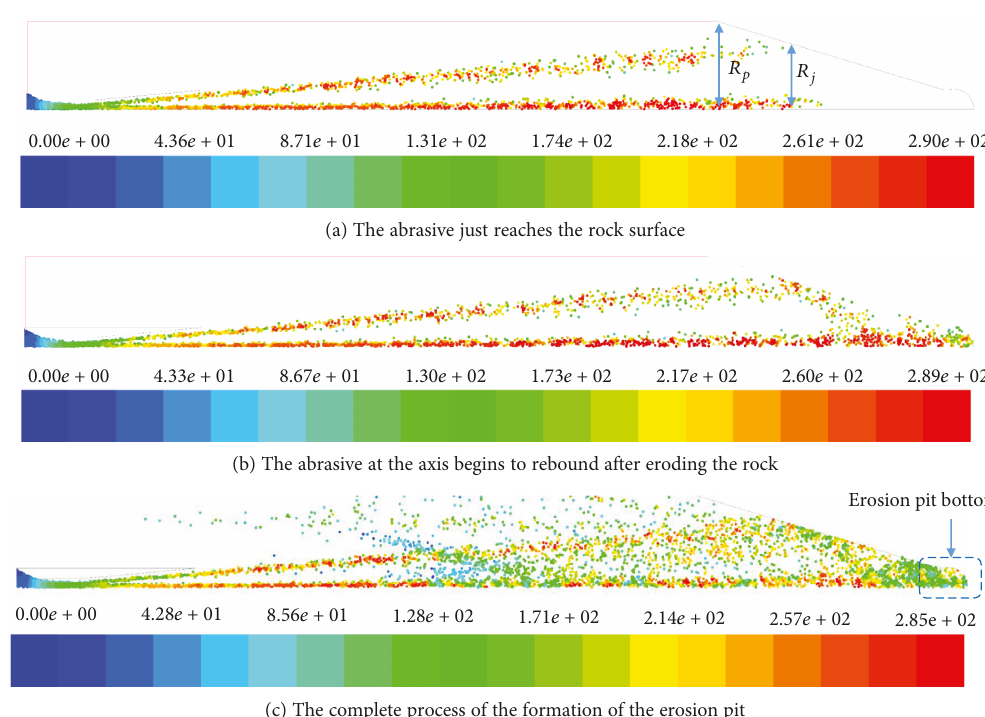
Figure 8: Flow fi eld structure and velocity distribution of the abrasive gas jets during erosion of the